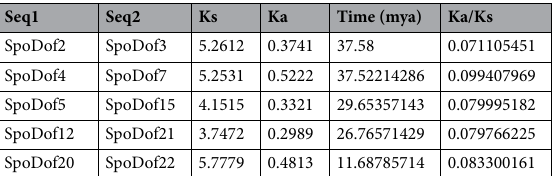
Table 2. The Ka/Ks value of SoDof genes (lower than 0.1). The details Ka/Ks information are shown in Supplementary Table S2.